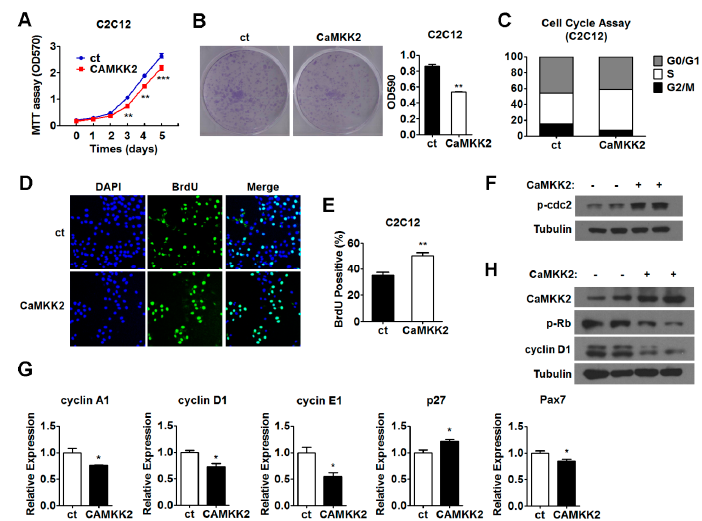
Figure 2. CaMKK2 inhibits C2C12 myoblasts proliferation. ( A ) MTT assay of the proliferation of C2C12 myoblasts transfected with CaMKK2 or control plasmids and maintained over a period of 5 days; ( B ) Representative micrographs of crystal violet-stained C2C12 cell colonies, which were transfected with CaMKK2 plasmids as indicated ( left ), absorbance of each well at 590 nm ( right ) ( n = 3); ( C ) Flow cytometric analysis of the C2C12 myoblasts transfected with CaMKK2 plasmids during proliferation. Percentage of cells in G1, S and G2 phases were analyzed ( n = 3); ( D , E ) DNA synthesis in C2C12 myoblasts transfected with CaMKK2 or control plasmids by BrdU incorporation assay. Representative images of BrdU immunofluorescence ( green ) and DAPI-stained nuclei ( blue ) ( D ); Quantification of the BrdU positive cells ( E , n = 3); ( F ) Representative western blot showing the p-cdc2 Tyr15 protein levels in C2C12 myoblasts transfected with CaMKK2 plasmids; ( G ) Quantitative RT-PCR analysis of cyclin A1, cyclin D1, cyclin E1, p27 and Pax7 mRNA levels in C2C12 myoblasts transfected with CaMKK2 plasmids ( n = 3); and ( H ) Representative western blot showing the cyclin D1 and p-Rb (Ser807/811) protein levels in C2C12 myoblasts transfected with CaMKK2 plasmids. Experiments were repeated at least twice. Means ± SEM (error bars) are shown. *, p < 0.05; **, p < 0.01, ***, p < 0.001.